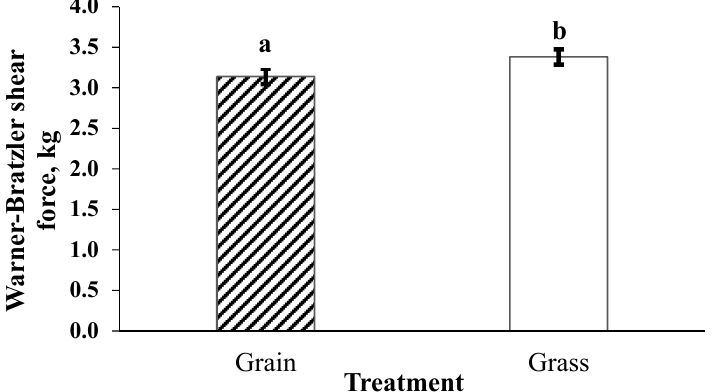
Figure 1. Least square means for the effect of finishing system on tenderness of bison striploin steaks. Treatments: GRAIN = bison heifers backgrounded on pasture and finished for 130 days with ad libitum access to grass hay, alfalfa, and a corn and dry distiller’s grain concentrate prior to slaughter. GRASS = bison heifers remained on pasture until slaughter. All steaks stored frozen prior to analysis. a,b means lacking a common superscript differ p < 0.05.